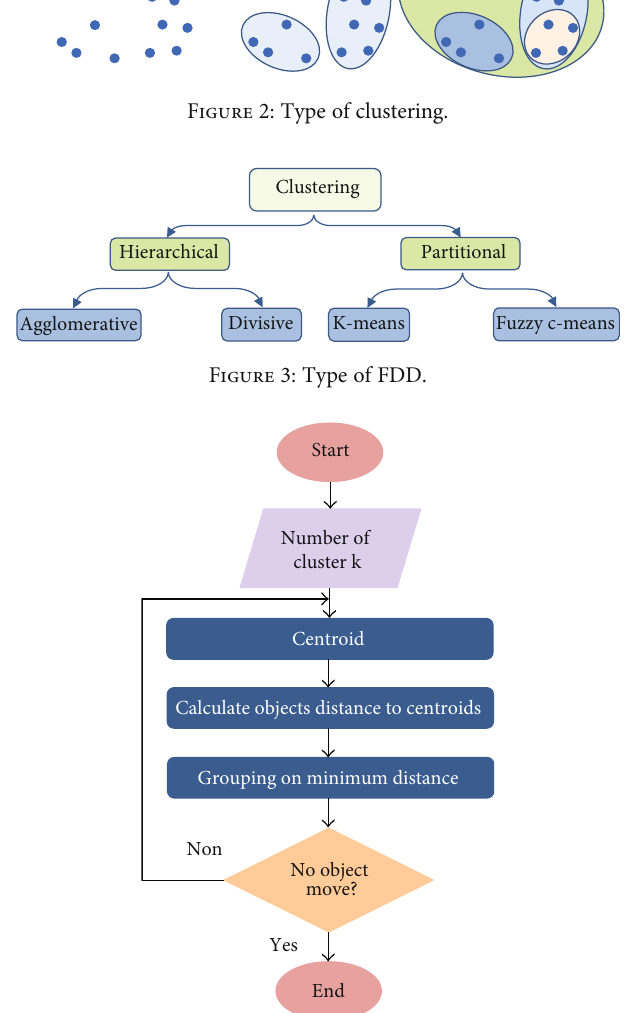
Figure 4: Flowchart of K-means